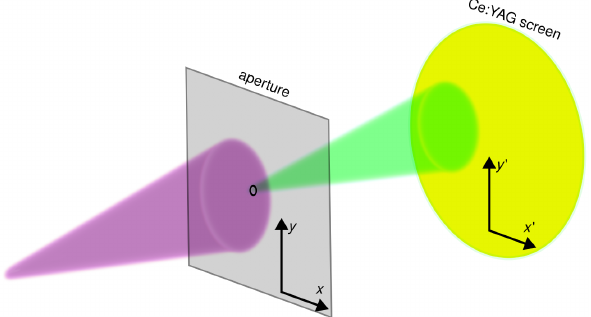
FIG. 2. A schematic of the method used to measure the four- dimensional transverse phase space density. The incident electron beam (purple) is rastered via a dipole magnet across a 10 - μ m diameter aperture in both transverse dimensions ( x , y ). An image of each transmitted beamlet (green) is captured on a downstream YAG ∶ Ce screen lens-coupled to a camera, which provides intensity and angular ( x 0 , y 0 ) information for each beamlet.